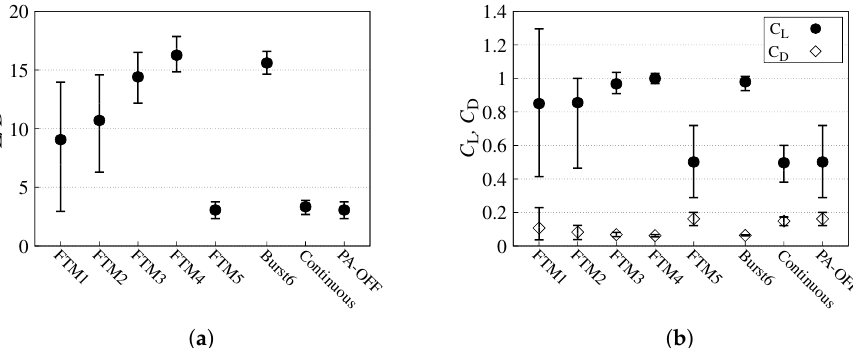
Figure 8. Aerodynamic characteristics in each FTM and reference cases at α = 12. ( a ) Lift-to-drag ratio ( L / D ). ( b ) Lift and drag coefficients ( C L and C D